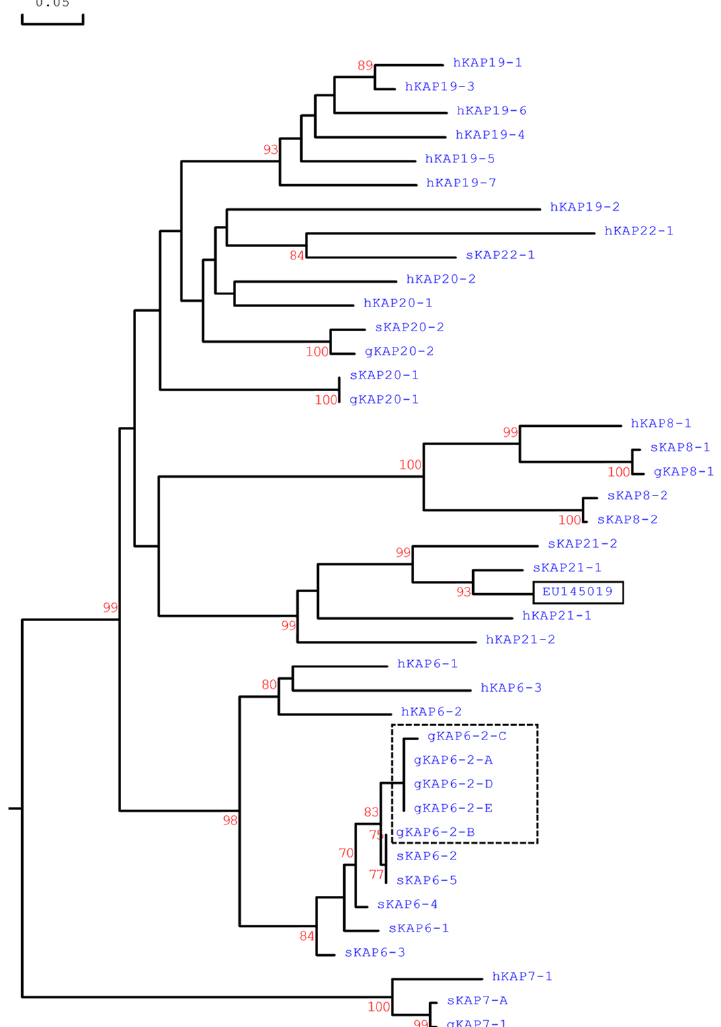
Figure 5. Phylogenetic tree of the newly identified caprine KAP6-2 variants, together with other HGT-KAPs identified in goats, sheep, and humans. The goat, sheep, and human KAPs are indicated with a prefix ‘g’, ‘s’, and ‘h’, respectively. The numbers at the forks show the bootstrap confidence value and only those ≥ 70% are shown. The scale bar indicates 0.05 amino acid substations per site. The caprine KAP6-2 variants are shown in a dashed box, and the GenBank accession numbers for other HGT-KAPs are: NM_001193399 (sKAP6-1), KT725827 (sKAP6-2), KT725833 (sKAP6-3), KT725838 (sKAP6-4), KT725841 (sKAP6-5), AY510121 (gKAP7-1), X05638 (sKAP7-1), NM_181606